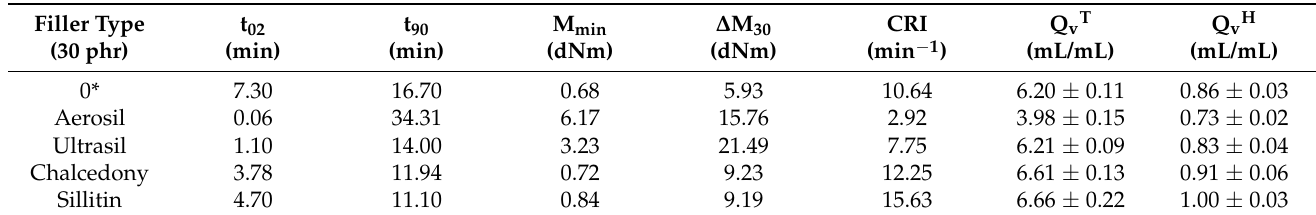
Table 6. The c ure characteristic of unfilled and filled CR/BR/nano-Fe 2 O 3 composites. Table 6. The cure characteristic of unfilled and filled CR/BR/nano-Fe 2 O 3 composites. Filler Type Filler Type